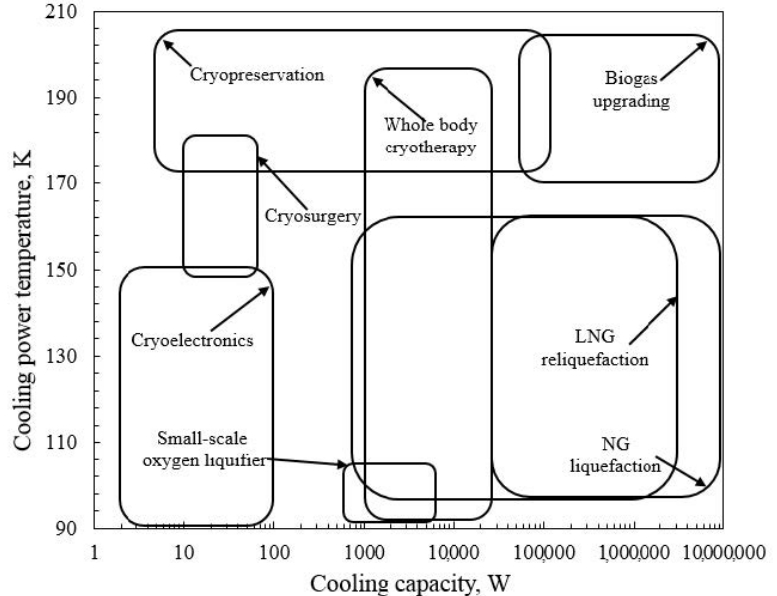
Figure 1. Overview of cryogenic applications above 110 K.